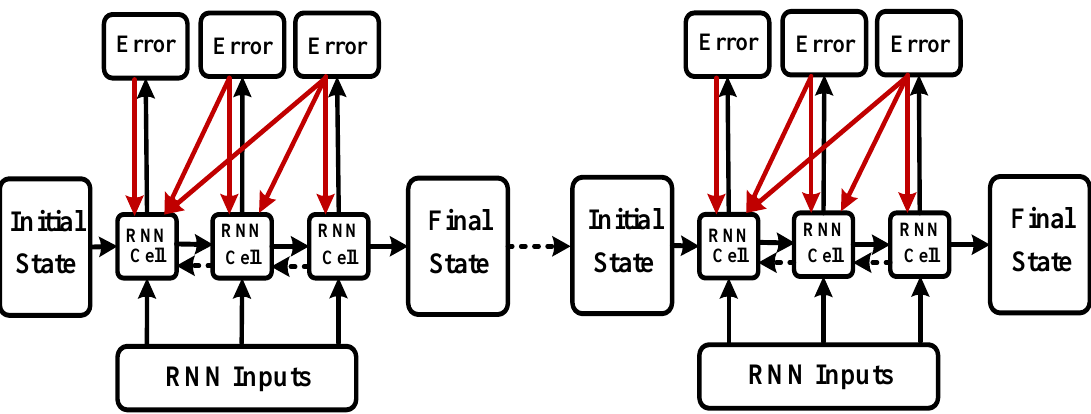
Figure 7. Bidirectional long short-term memory recurrent neural network (BI-LSTM-RNN) batch-training diagram.